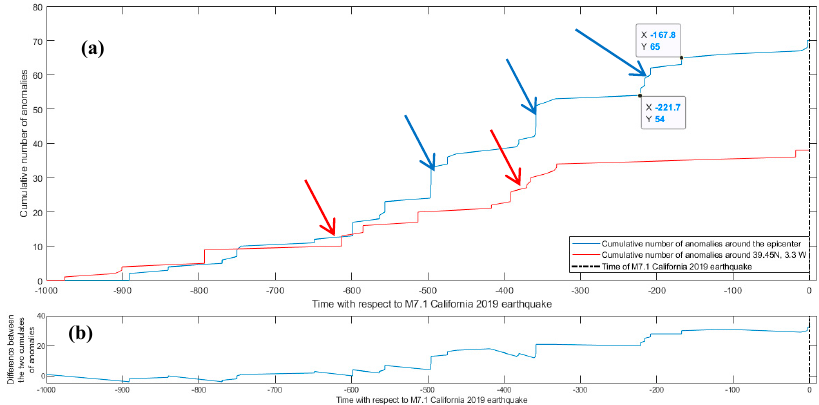
Figure 2. ( a ) Cumulative number of anomalies in a circular area of 3.34 degrees around the M7.1 California 2019 epicentre (blue line) compared with a comparison area on the opposite coast side of the US at the same magnetic latitude and with the same extension (red line). The arrows indicate the principal jumps discussed in the main text with the same colour of the cumulate curve. ( b ) Difference between the two cumulates.